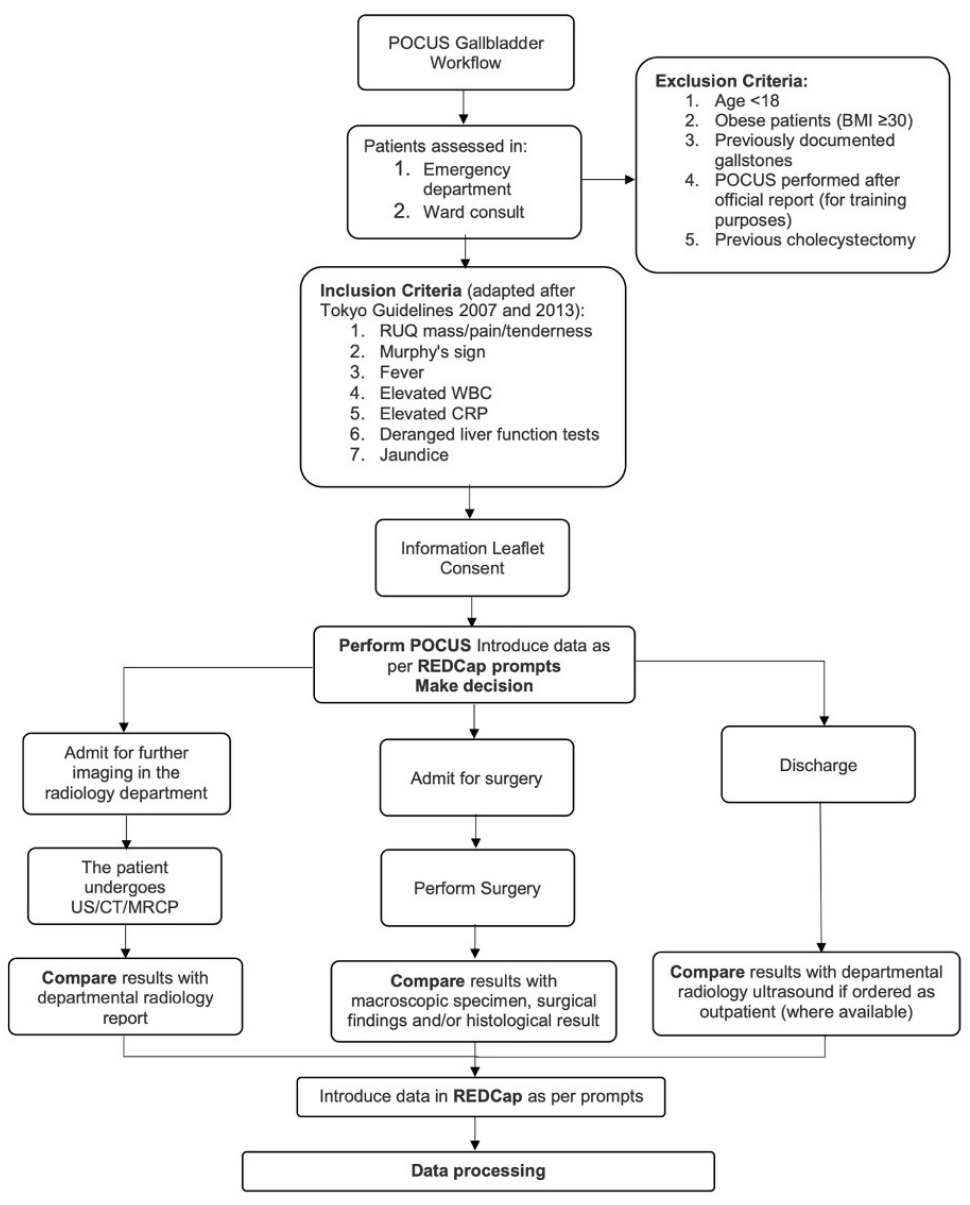
Figure 1. Study Figure 1. Study Workflow.